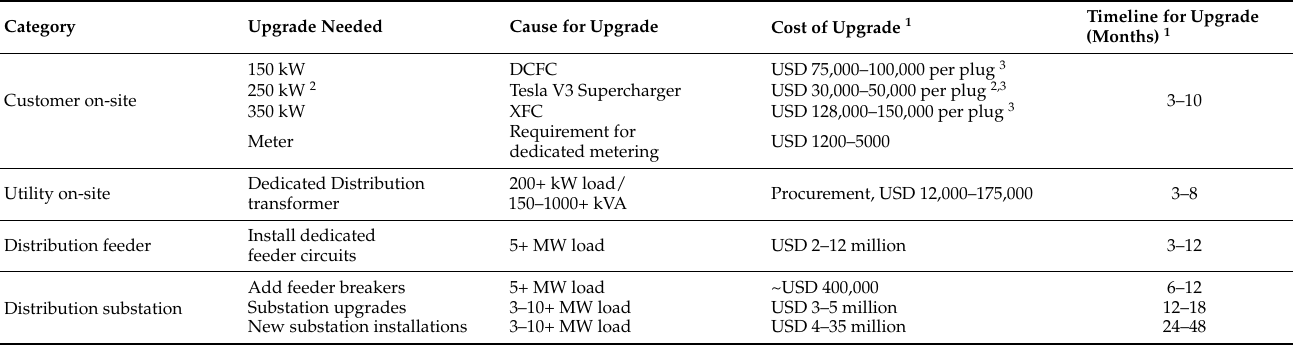
Table 1. Summary of distribution upgrades needed for fast charging stations